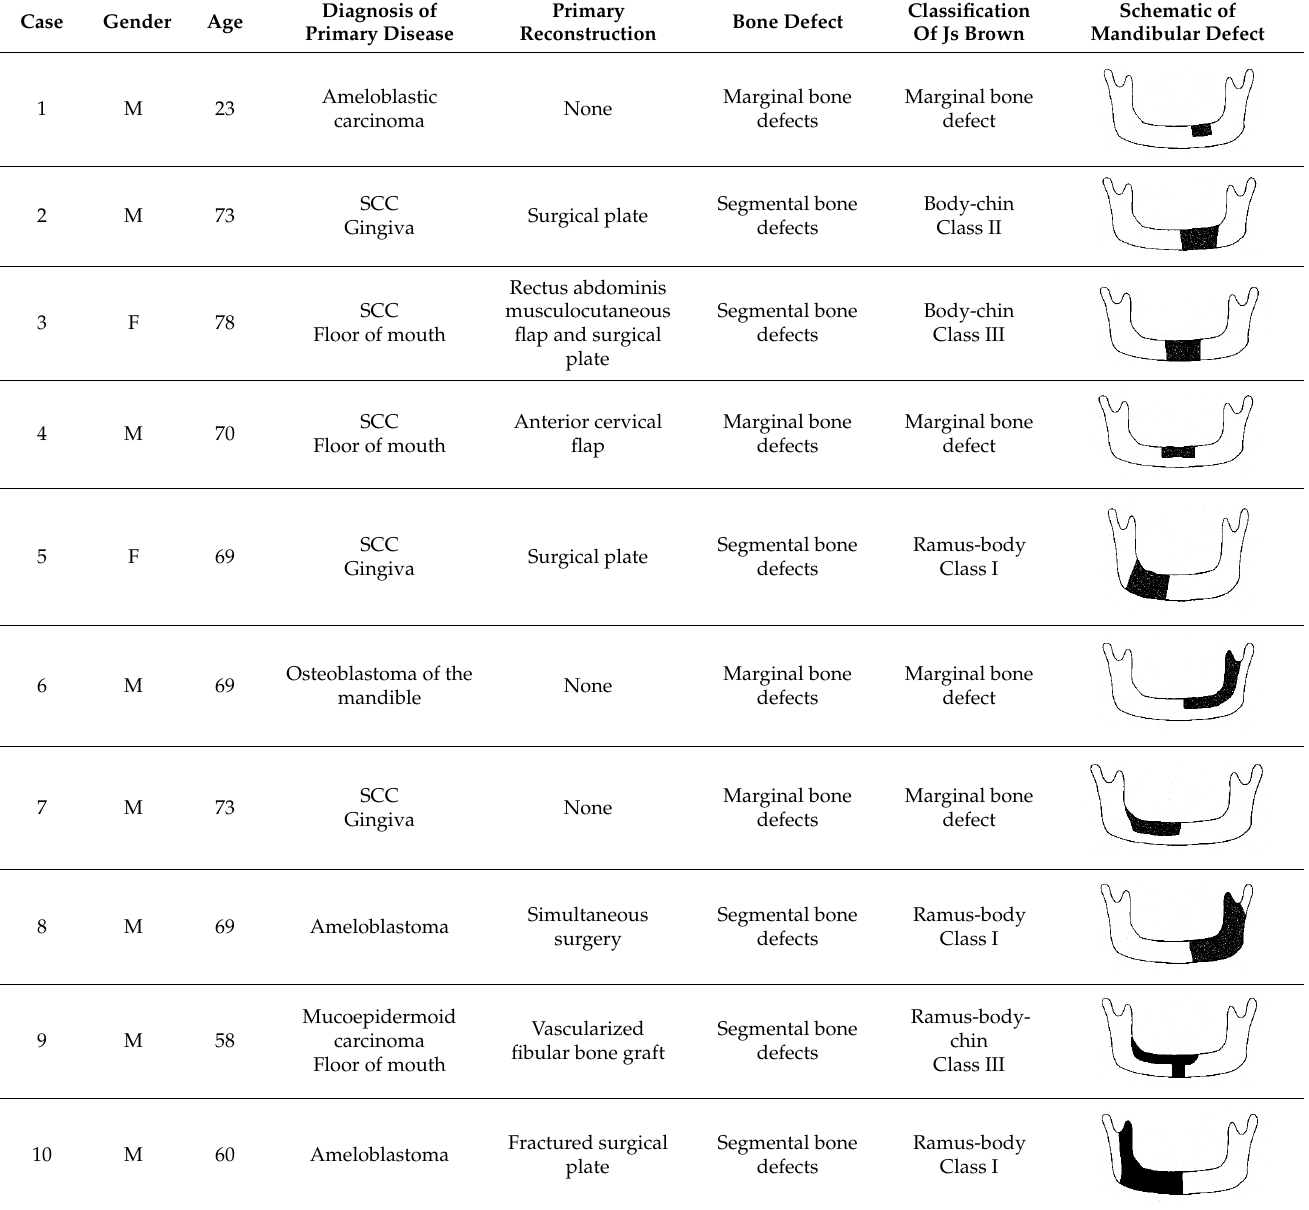
Table 1. Primary patient characteristics of lesions.